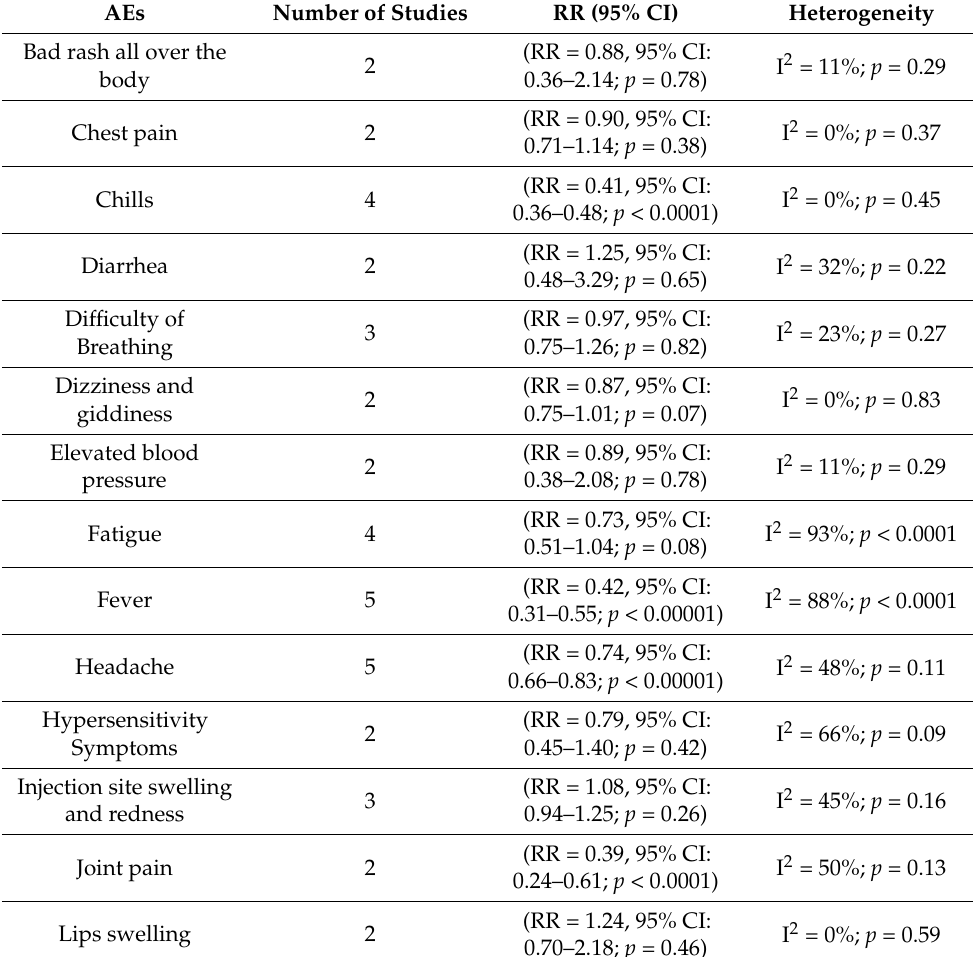
Table 4. Dose-dependent